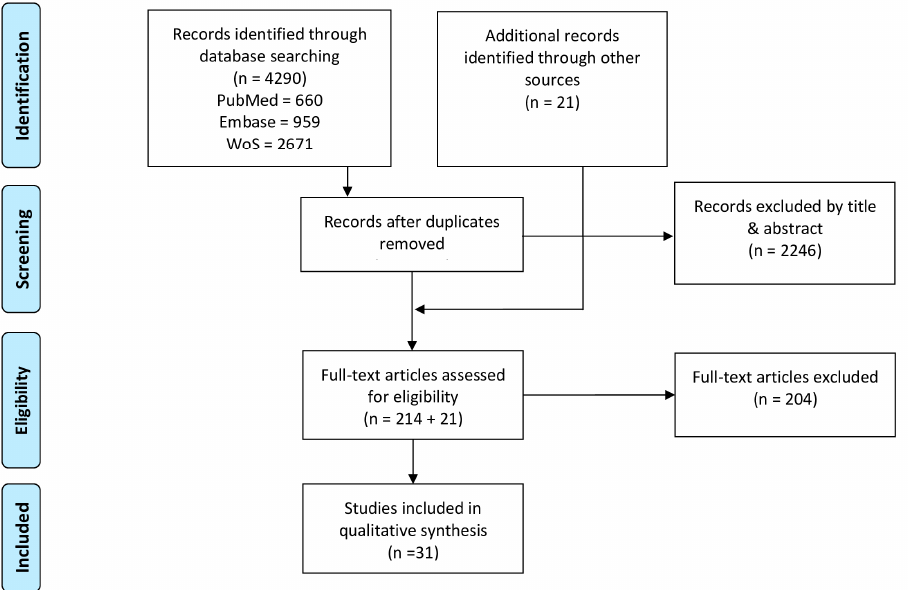
Figure 1. Preferred Reporting Items for Systematic review and Meta-Analyses (PRISMA) flowchart of the search strategy and study selection procedure, adapted from [15].